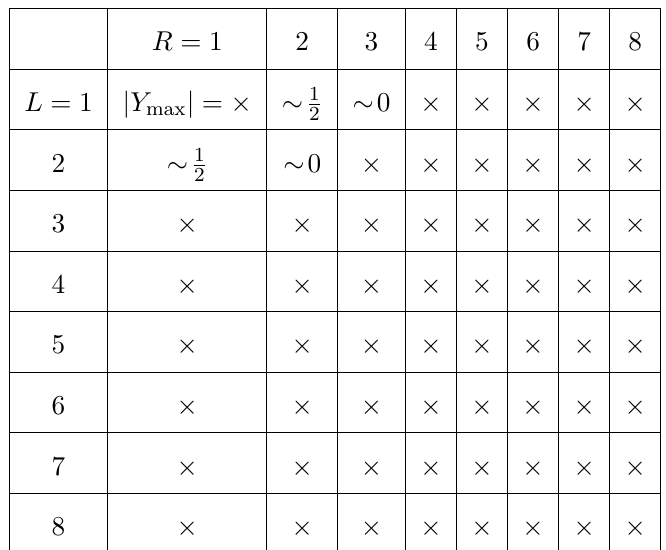
Table 12 . The representations for the vector-like fermionic BSM Loryons still viable after consid- ering direct search constraints. A ∼ means the representation is not viable on its own but can be added together with other BSM representations to flip the sign of κ